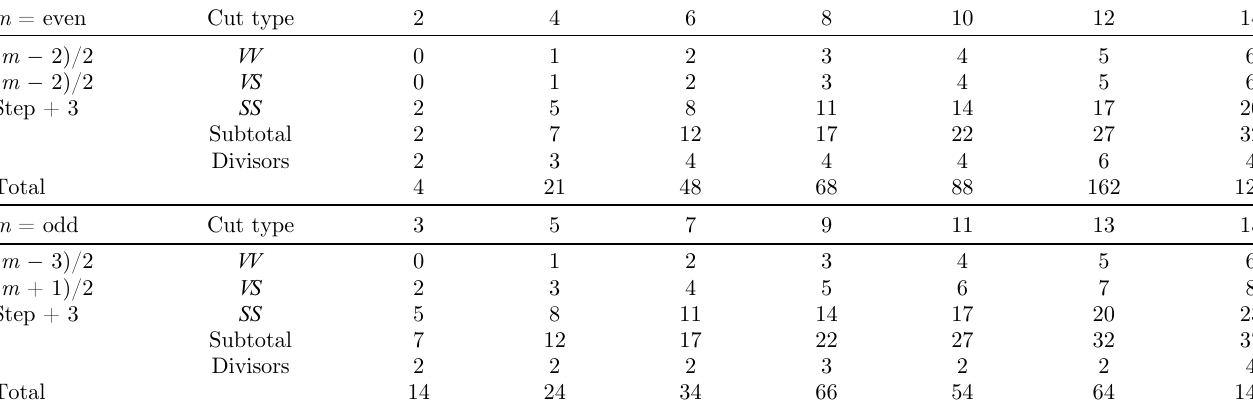
Table 11. Number of possible cuts for even and odd m